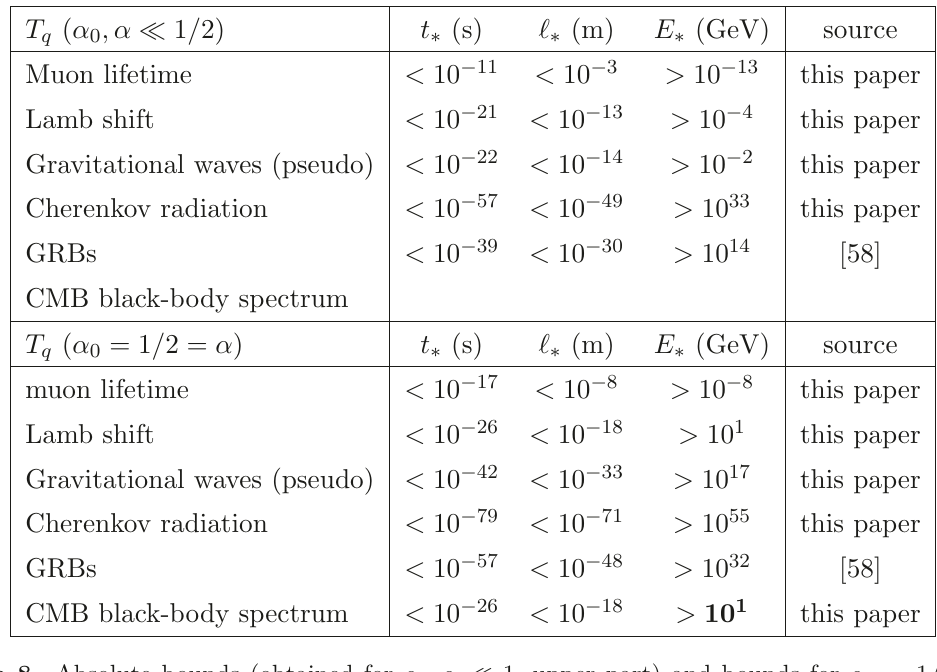
Table 8 . Absolute bounds (obtained for α 0 , α ≪ 1, upper part) and bounds for α 0 = 1 / 2 = α (lower part) on the hierarchy of multifractional spacetimes with q -derivatives with measure (9.2). The key formulæ used to compute the constraints in the table are: for the muon lifetime, t ∗ < ( uδτ/τ α 0 ) 1 / (1 − α 0 ) replacing eq. (139) of [56], with u = 1; for the Lamb shift, E ∗ > { uδE/ [(2 0